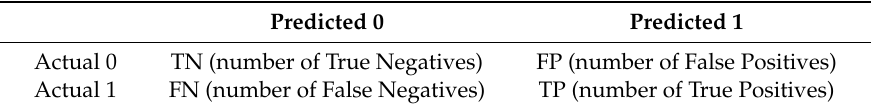
Table 5. Confusion matrix for two classes